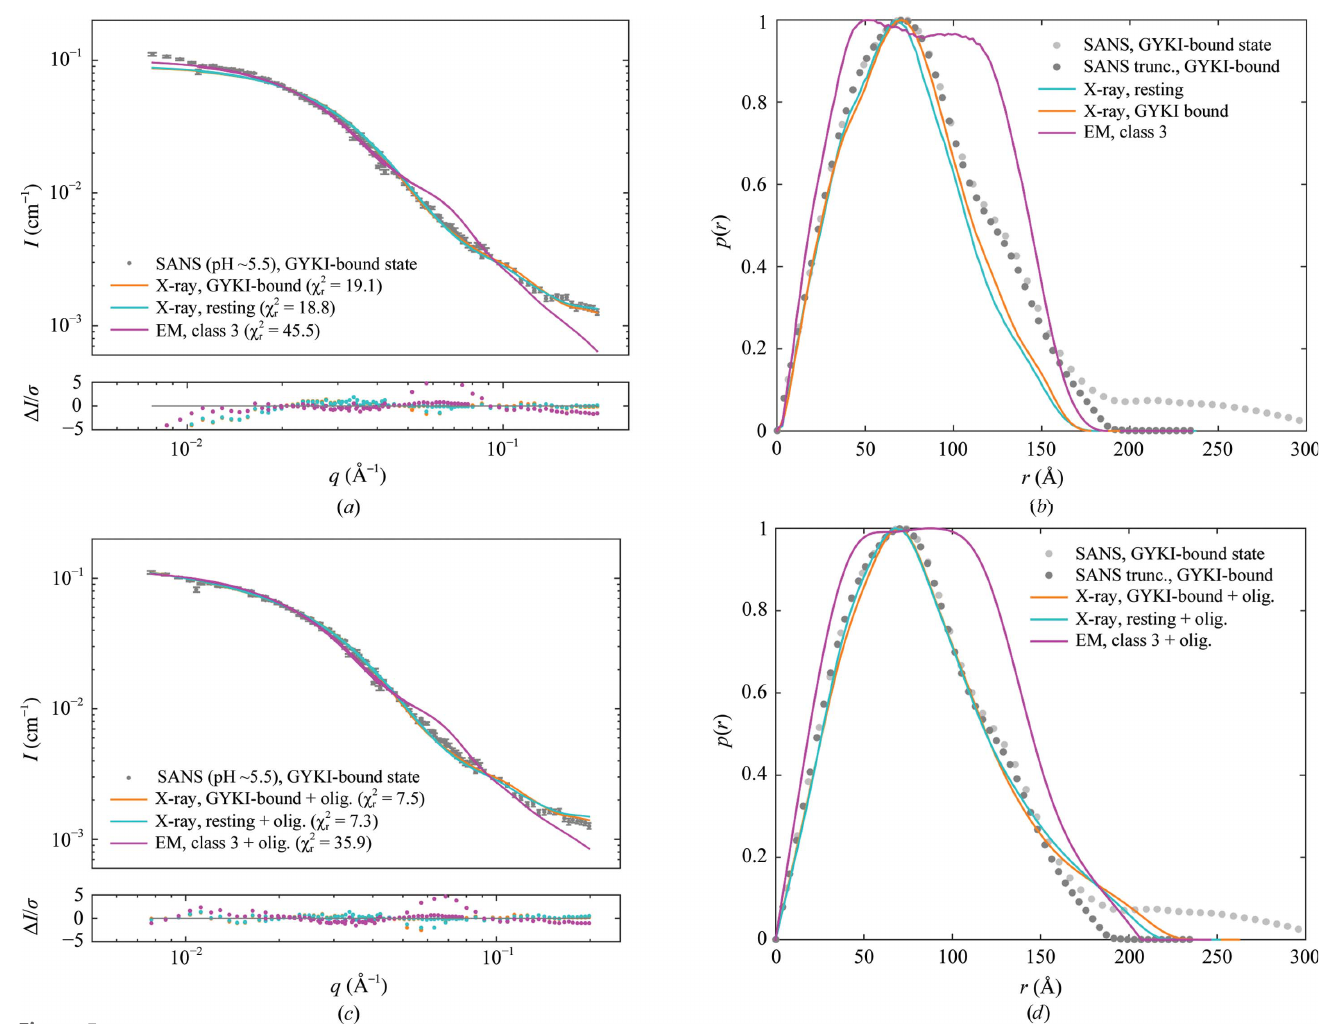
Figure 5 SANS data for GluA2 in the presence of GYKI-53655. ( a ) Experimental SANS data (grey points) and the resulting structure fits and residual plots for the X-ray crystal structures of GluA2 with GYKI-53655 bound (PDB entry 5l1h; orange; Yelshanskaya et al. , 2016), GluA2 in the resting state (PDB entry 4u2p; cyan; Du¨rr et al. , 2014) and GluA2 in the class 3 EM structure (EMD-2688; magenta; Meyerson et al. , 2014). ( b ) p ( r ) functions for the SANS data (light grey) and for a truncated data set ( q (cid:9) 0 : 0 12 A˚ (cid:5) 1 ; dark grey) and the theoretical p ( r ) functions for the two X-ray structures and the class 3 EM structure. ( c ) SANS data (grey points) and fits with a linear combination of the three structures and fractal oligomers. ( d ) p ( r ) functions for the SANS data (nontruncated and truncated) and for the linear combinations of the three structures and fractal